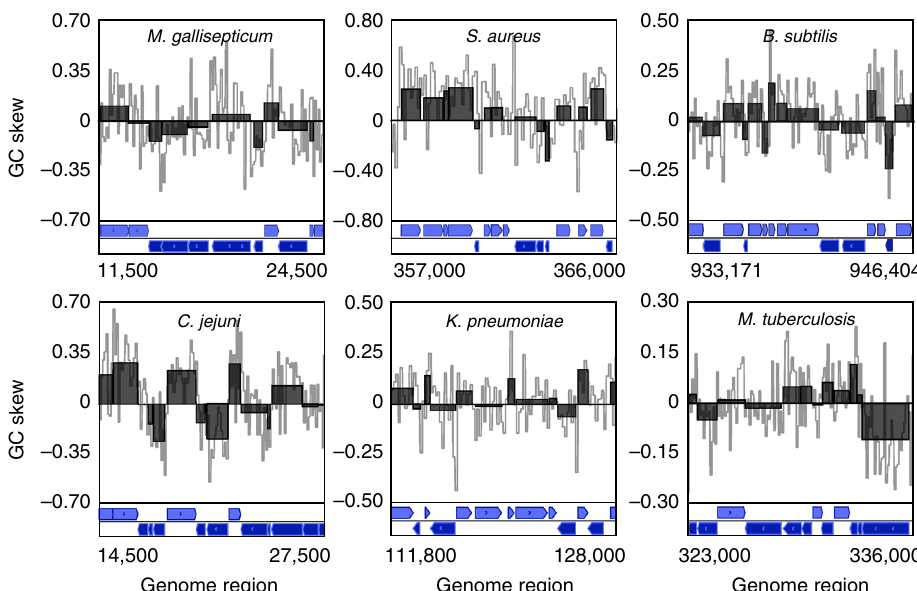
Fig. 2 Inverted GC skew values correlate with genes in the head-on orientation. GC skew values are either shown in gray (100 bp step size) or as an average over whole genes (black). The locations of individual genes and their coding strand are indicated below. For each species, head-on genes are annotated on the lower box (transcribed right to left, dark purple), and co-directional genes are on the upper box (light